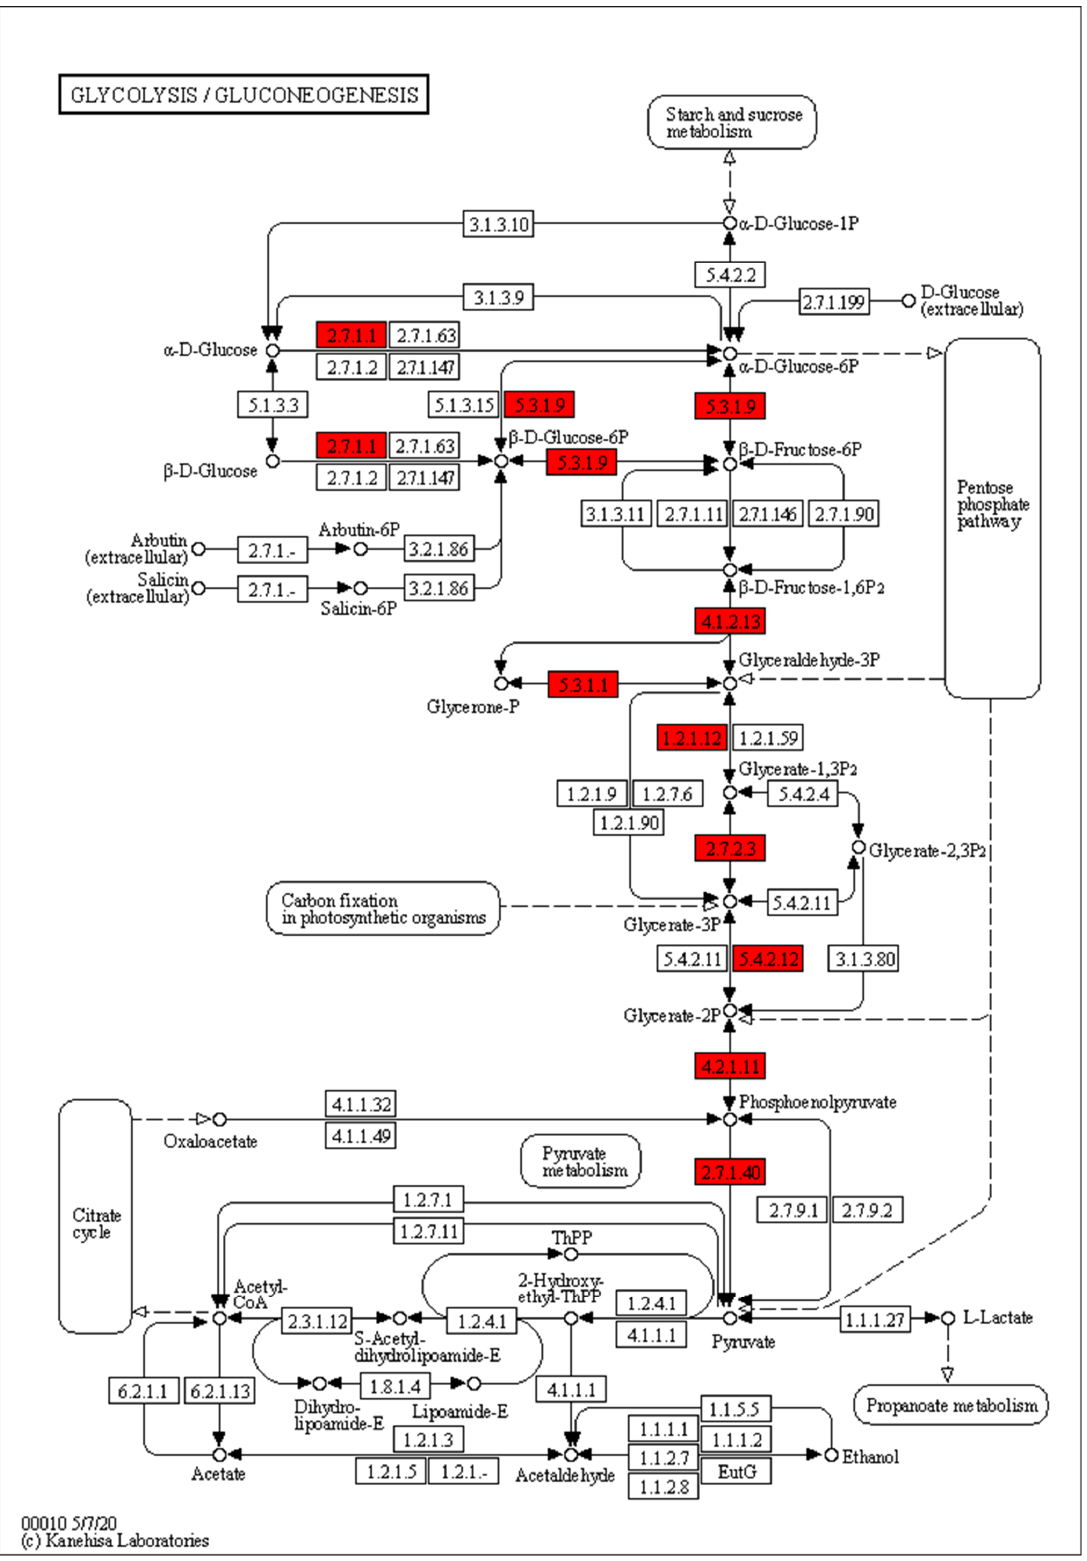
Figure 5. Genes of cluster 6 and cluster 7 involved in the glycolytic process pathway. The genes of cluster 6 and cluster 7 in the pathway are marked in